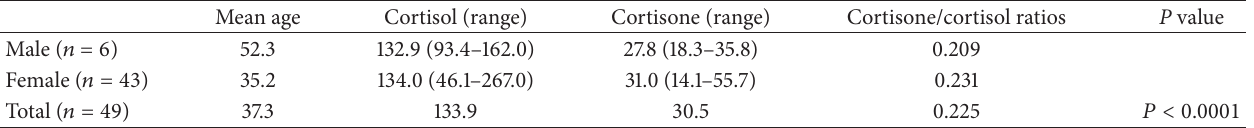
Table 2: Mean concentrations (ng/mL) of cortisol and cortisone in serum collected between 9:00 and 11:00a.m. Mean age Cortisol